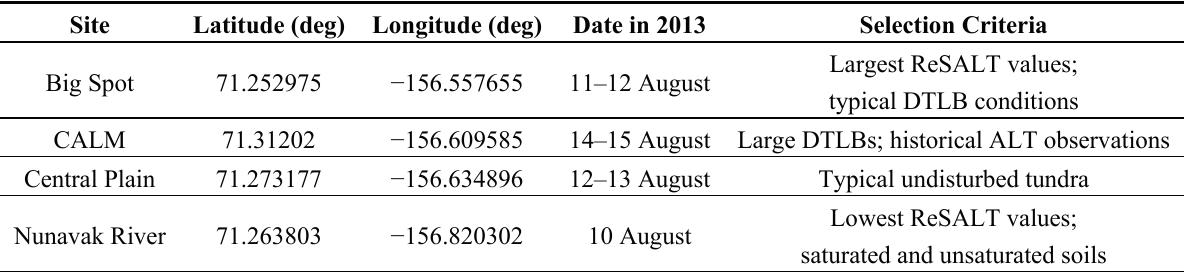
Table 1. ReSALT Validation